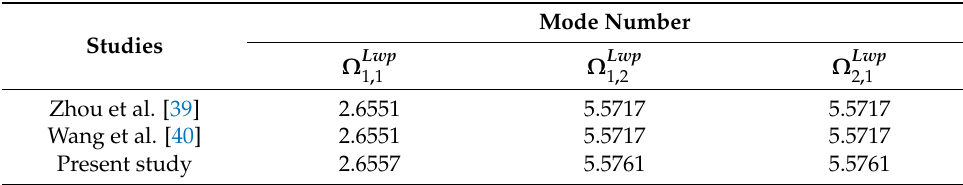
Table 2. Comparison of dimensionless frequency parameters for square plates on a PF ( h / b = 0.01, a / b = 1, k w = 100 D m , k p = 10 D m